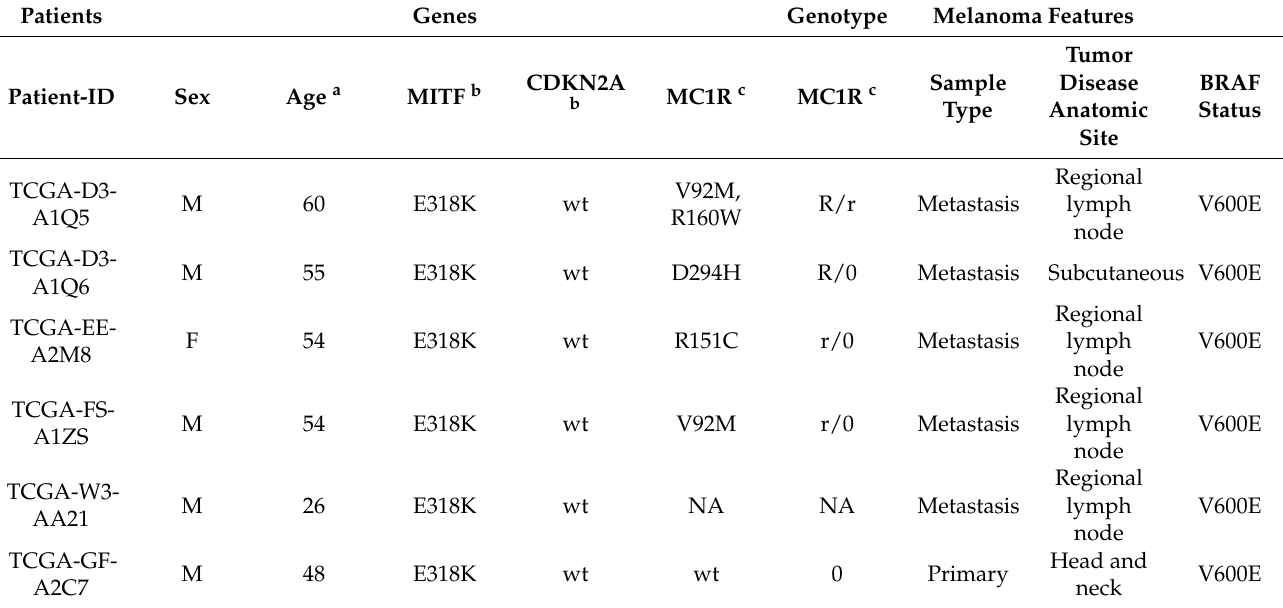
Table 3. MITF-E318K carriers of SKCM-TCGA Pan Cancer Atlas